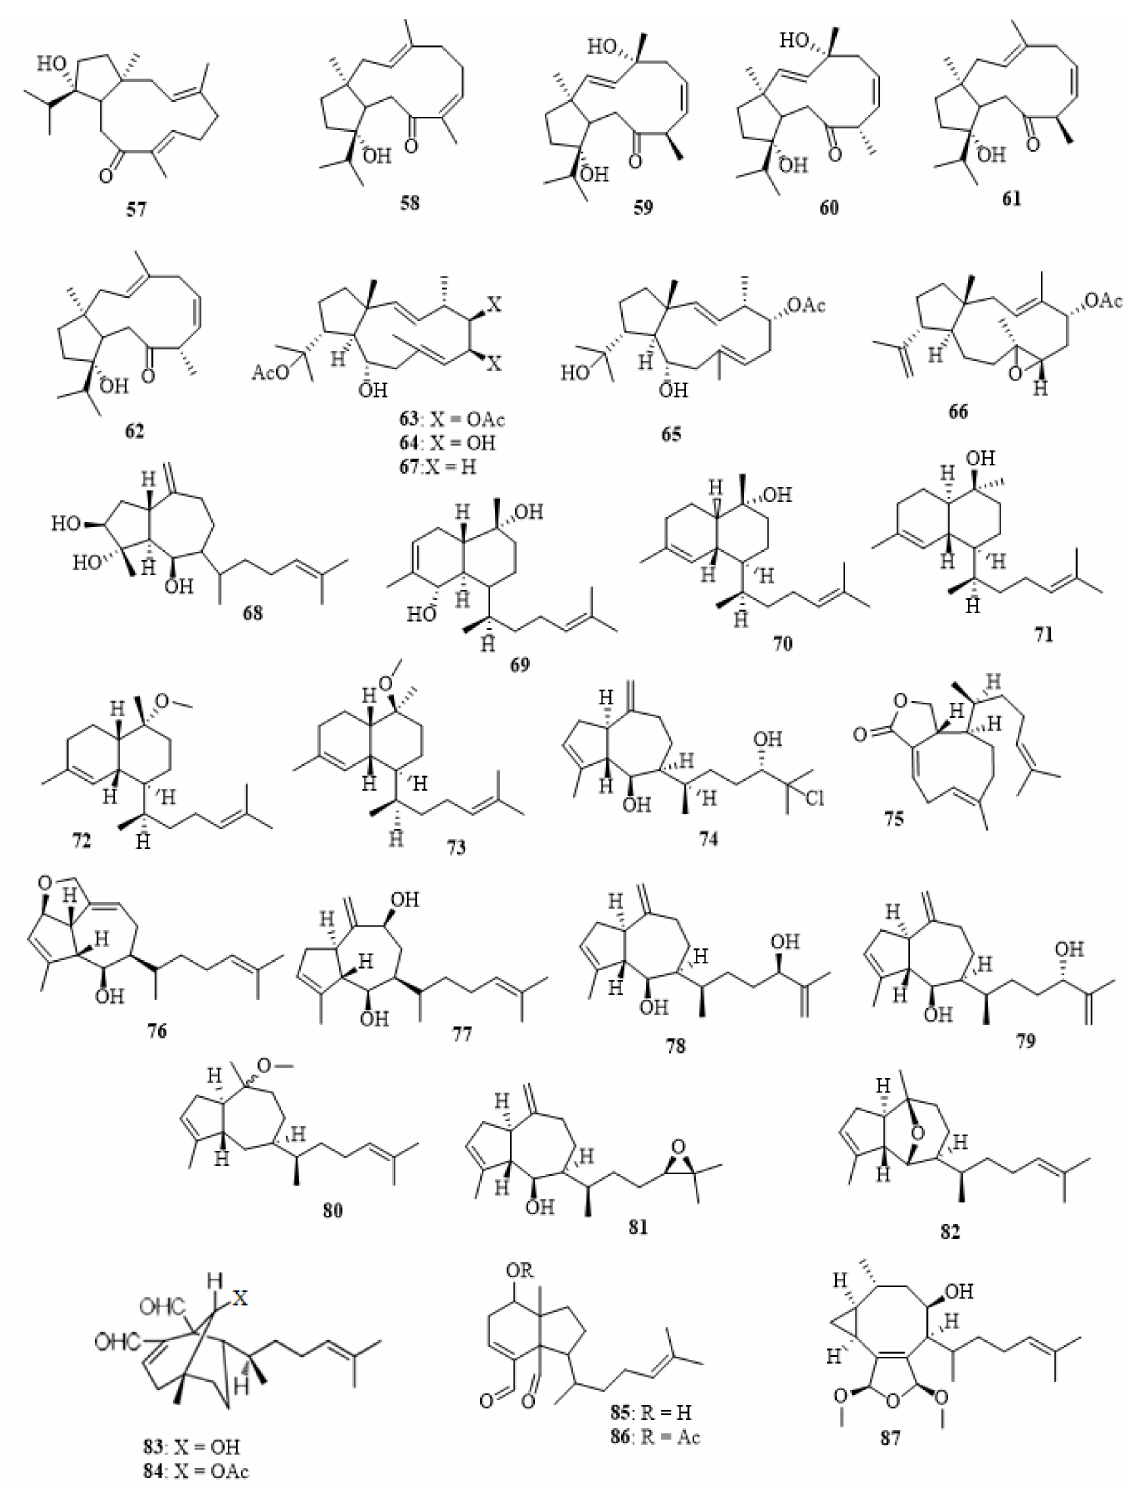
Figure 4. Chemical structures of compounds 57 – 87 . The diterpenes 57 – 87 were isolated from D. dichotoma . The configuration of all stereocenters in each compound is shown as given in the literature. Dictyotin A ( 69 ), dictyotin B ( 70 ), dictyotin C ( 71 ), methoxydictyldiene ( 72 ) and dicty- otin D methyl ether ( 73 ) (Figure 4), were isolated from D. dichotoma collected in Yagachi, Okinawa [47]. The chlorine-containing perhydroazulene diterpene dictyol J ( 74 ), dictyolac- tone ( 75 ), and sanadaol ( 36 ) were identified in the ethanolic extract of D. dichotoma